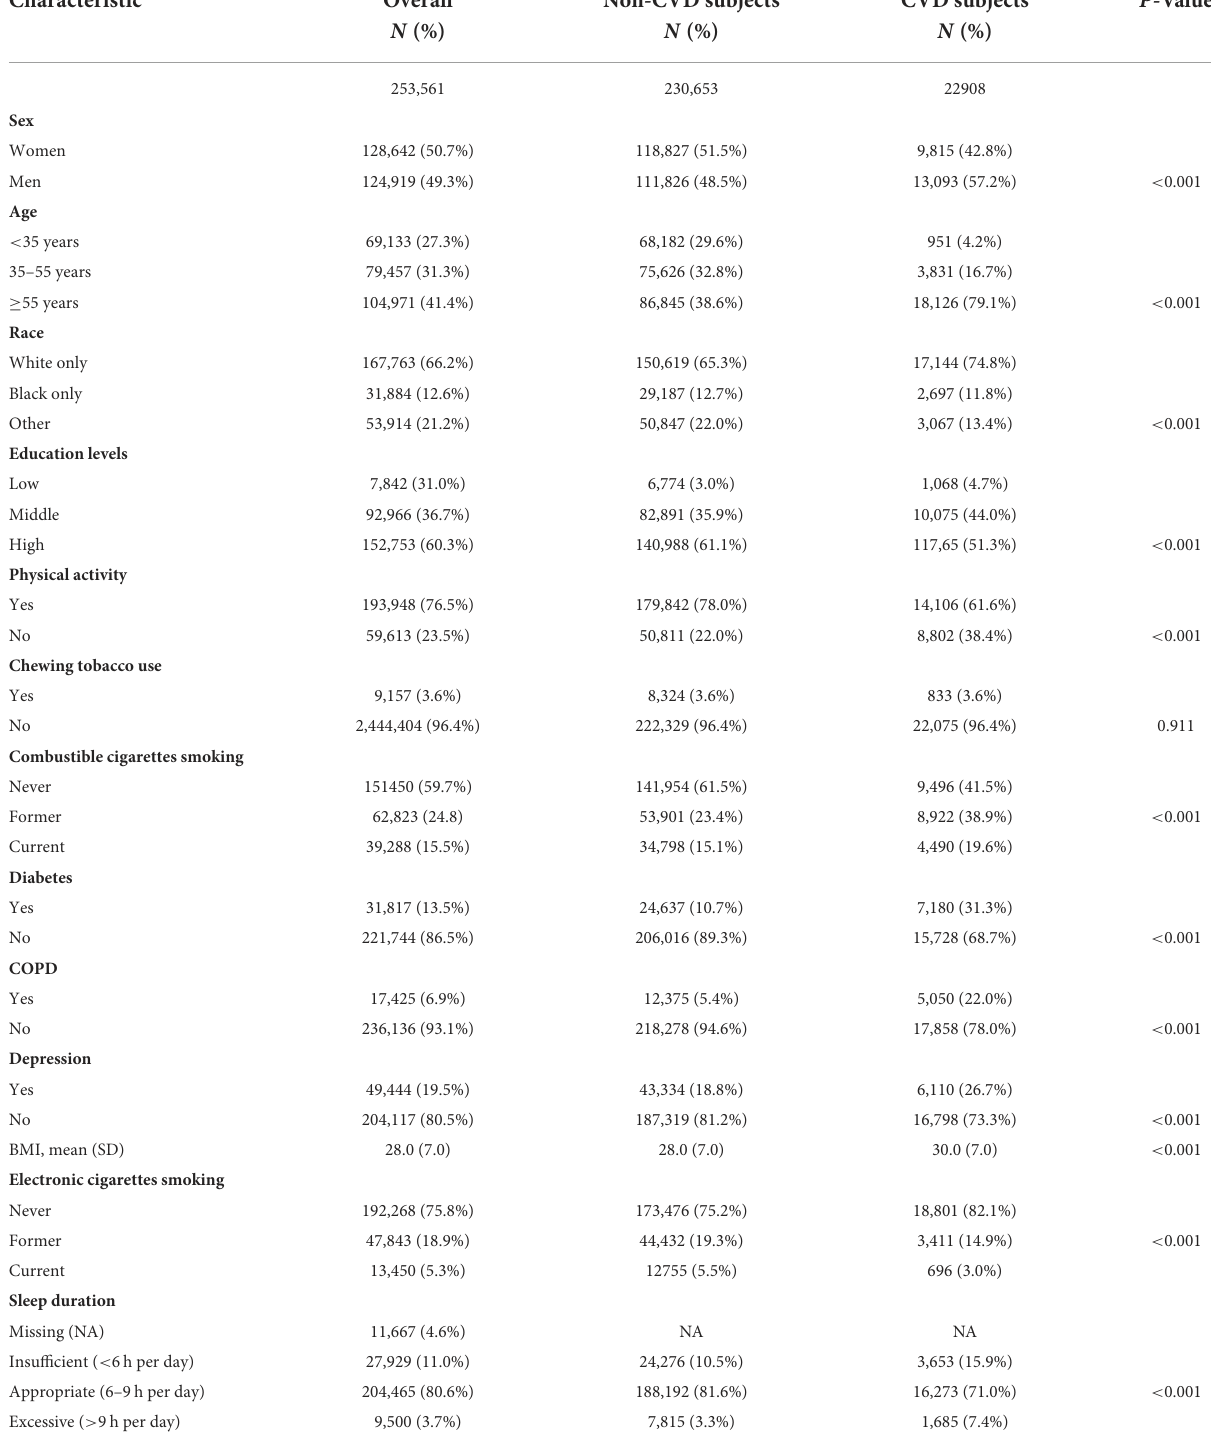
TABLE 1 Sociodemographical characteristics, electronic cigarette use, and sleep duration of the study